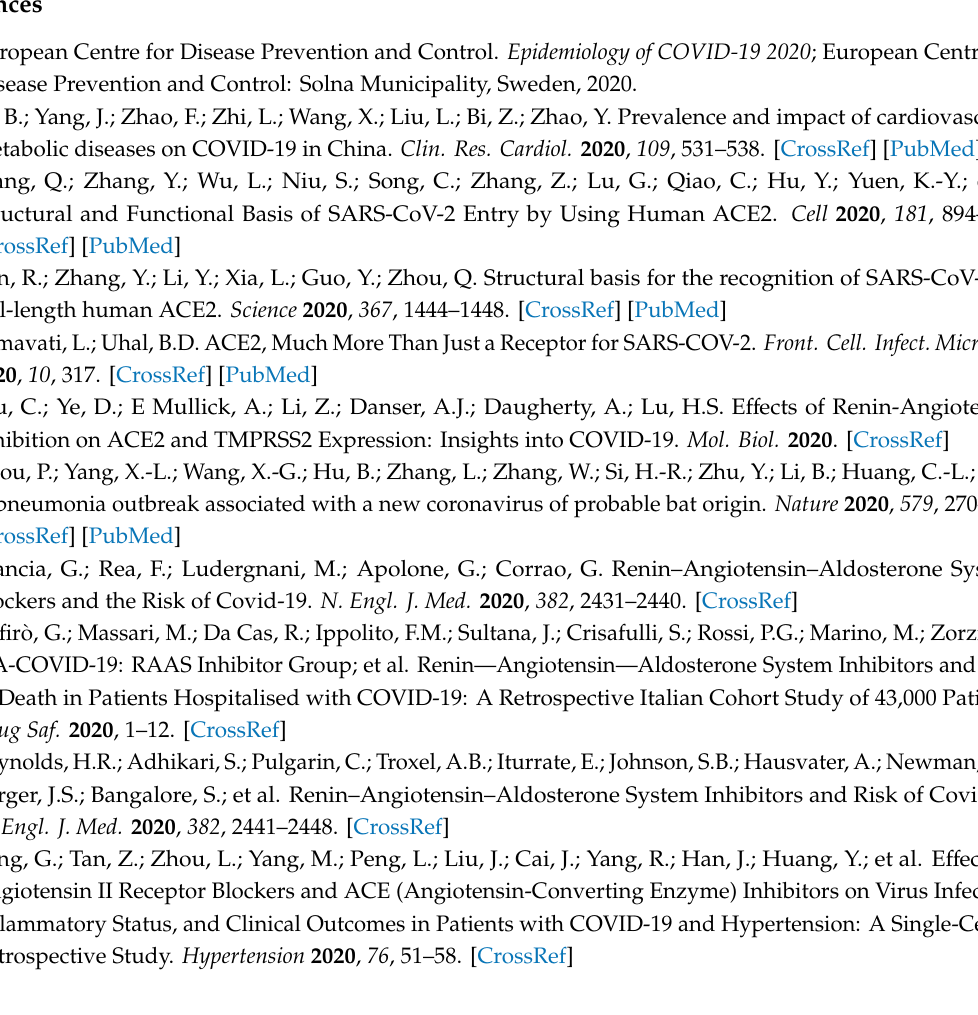
Table S1: Univariate and multivariate analysis of baseline risk factors for death, Table S2: Univariate and multivariate analysis of baseline risk factors for severe pneumonia (death and / or OTI and / or NIV and / or HFNO and / or oxygen flow of at least 5 L /